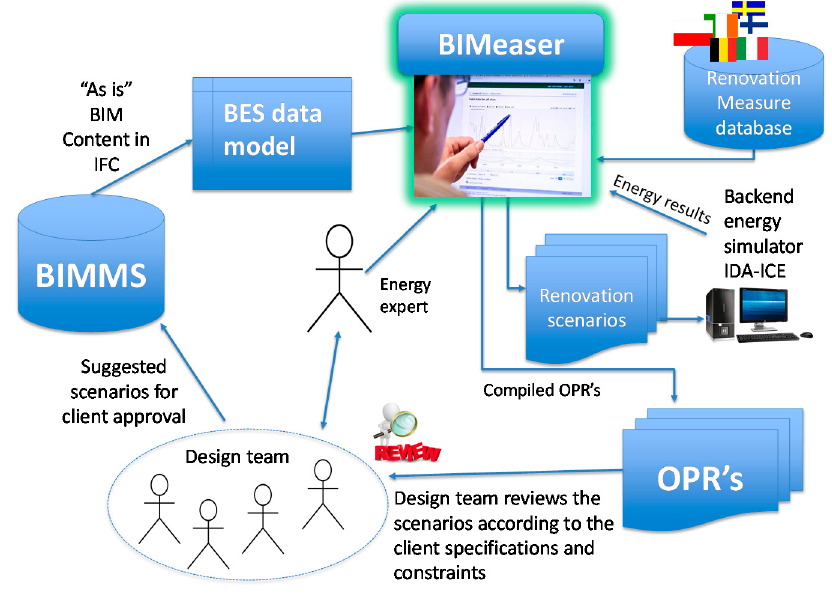
Figure 1. BIMeaser tool main data flow and